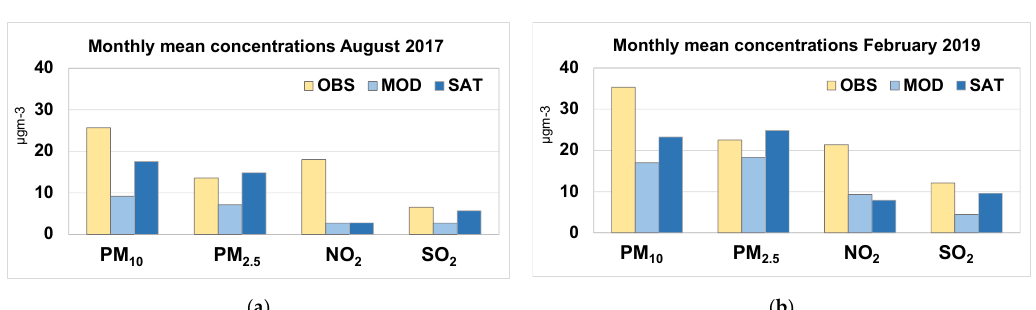
Figure 8. Monthly mean concentrations (μgm −3 ) from observations (OBS), and from models: BgCWFS_mod (MOD) and BgCWFS_sat (SAT): ( a ) August 2017; ( b ) February 2019. In Figures 9 and 10, the comparison for PM 10 and SO 2 at three selected stations (see Figure 4) for August 2017 is shown. PM 10 values from BgCWFS_sat were underestimated at all stations, but to a lesser extent than the values from BgCWFS_mod (average NMB values −31.7% and −64.3%, respectively). The station with the highest underestimation from BgCWFS_sat (NMB −47% for PM 10 and −37% for SO 2 ) was Plovdiv-Kamenitza, which indicates that air pollution at this site was more influenced by local factors, not captured by the system with 9 km resolution. Similar plots for PM 2.5 (Figure S5) confirm general improvement from BgCWFS_sat, especially at the urban sites. As already shown by the distribution maps, NO 2 was underestimated by both model versions by a factor of 6 on average for the selected stations (Figure S6). For February 2019, the comparison of PM 10 and PM 2.5 (Figures S7 and S8) showed better matching from BgCWFS_sat compared to the observations at the Sofia-Hipodruma station with absolute value of the NMB less than 8%. For Plovdiv-Kamenitza station, significant underestimation of PM from BgCWFS_sat was still observed (NMB −55% on average). At Sofia-Kopitoto mountain station, PM concen- trations from BgCWFS_sat were overestimated by a factor of about 3. At Sofia-Drujba and Plovdiv-Kamenitza stations, NO 2 (Figure S9) was underestimated by both model versions with NMB of about −75%. BgCWFS_sat led to clear improvement of SO 2 at Plovdiv-Ka- menitza station (Figure S10) with NMB decreasing from −64% to −36%. For the other two stations (Sofia-Drujba and Sofia-Kopitoto), the assimilation of satellite data resulted in overestimated SO 2 with an average NMB of 55%.